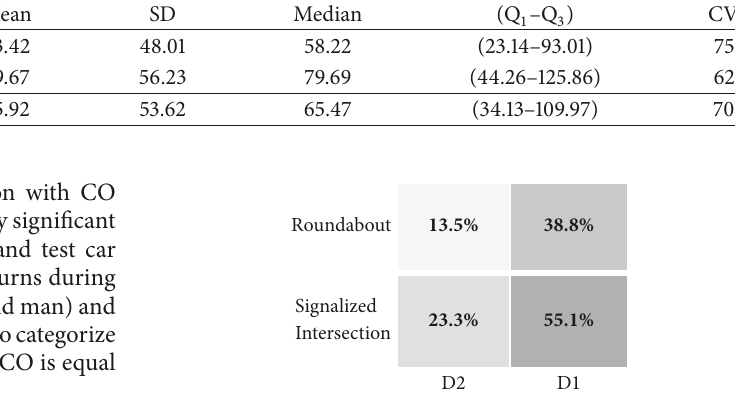
Figure 6: Probabilities of CO (mg) ≥ 129 mg (traffic condition =